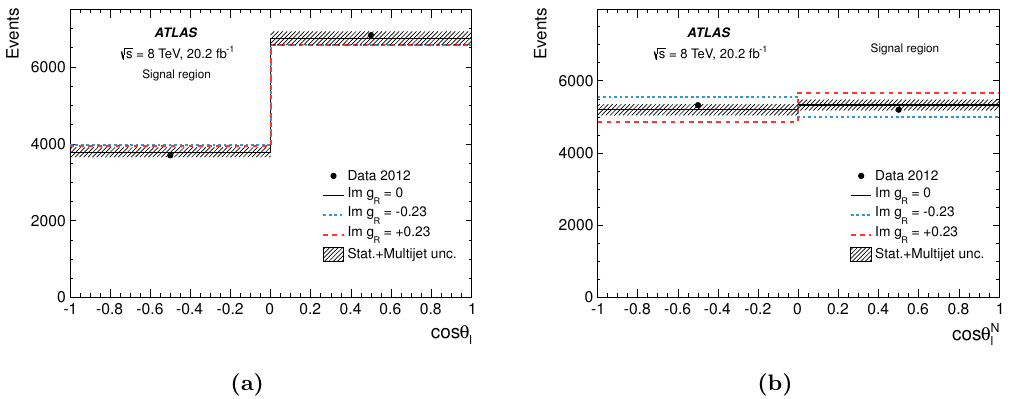
Figure 8. Comparison of the distributions observed in the signal region with the distributions predicted as a function of Im g R for the angular observables from which the asymmetries used to set limits on this coupling are measured: (a) cos (cid:18) ‘ for A ‘ distributions are determined by adding the signal and background contributions normalised to the results of the maximum-likelihood (cid:12)t. The template signal distributions are taken from the Protos samples generated with Im g R = 0 (Standard Model parameterisation) and Im g R = corresponding parton-level values for the A N the predicted values are 0.45 for Im g R = 0 and 0.34 for Im g R = include the statistical post-(cid:12)t uncertainty, the uncertainty due to the limited size of the simulation samples and the uncertainty in the normalisation of the multijet background, added in